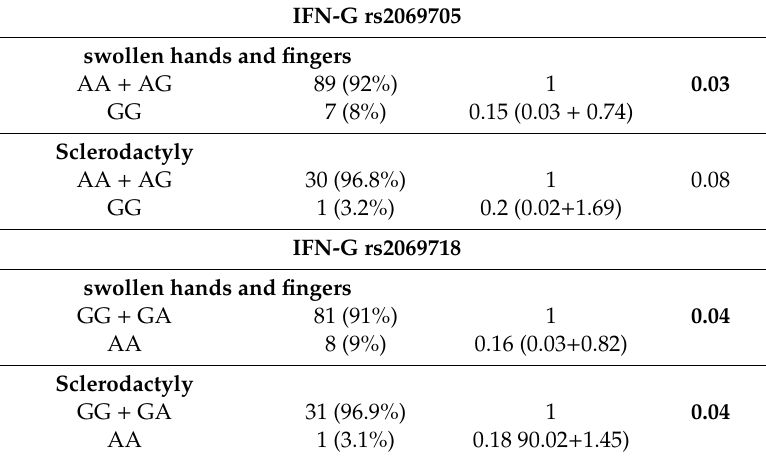
Table 7. Correlation between IFN-A, IFN-B, IFN-G genotypes (recessive model) and clinical pathology parameters in